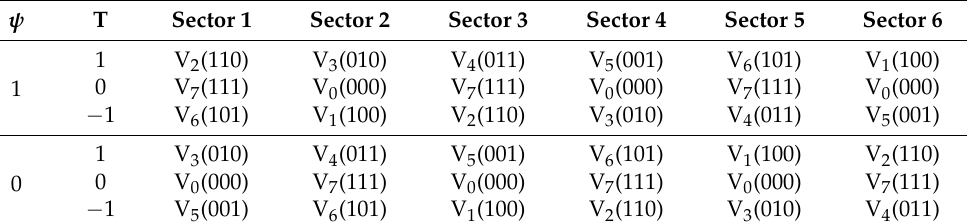
Table 1. Direct torque control (DTC) switching table.